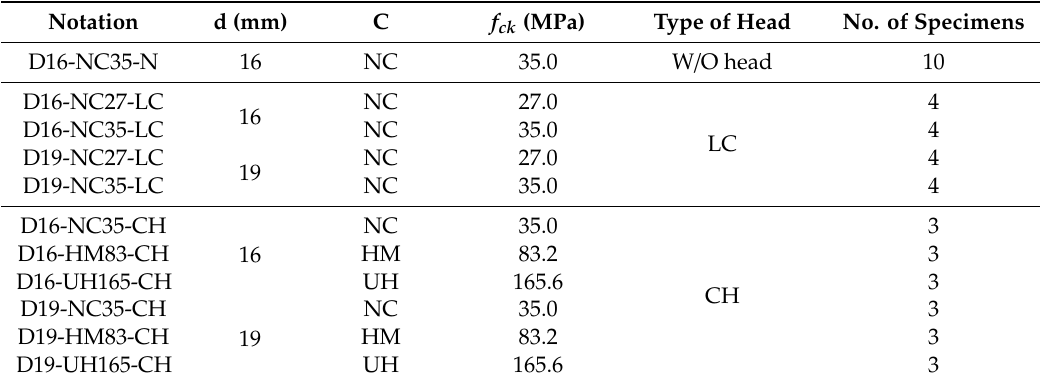
Table 1. Mechanical properties of test specimens.